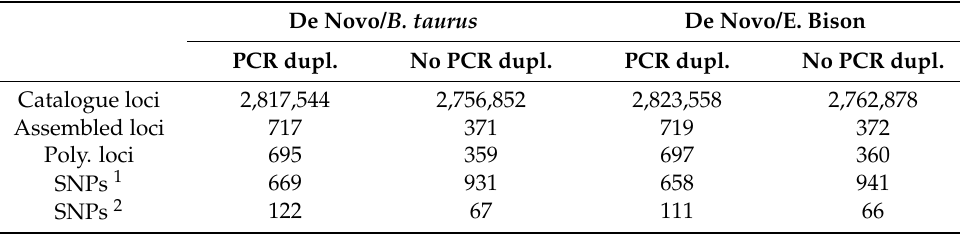
Table 2. Comparison of obtained numbers of catalogue loci, assembled loci, polymorphic loci, and SNPs using two de novo integrated approaches: ( Bos taurus and European bison (E. bison) genome used as reference genome), with and without PCR duplicates (PCR dupl. and no PCR dupl.). De Novo/ B. taurus De Novo/E. Bison PCR dupl. No PCR dupl. PCR dupl. No PCR dupl.